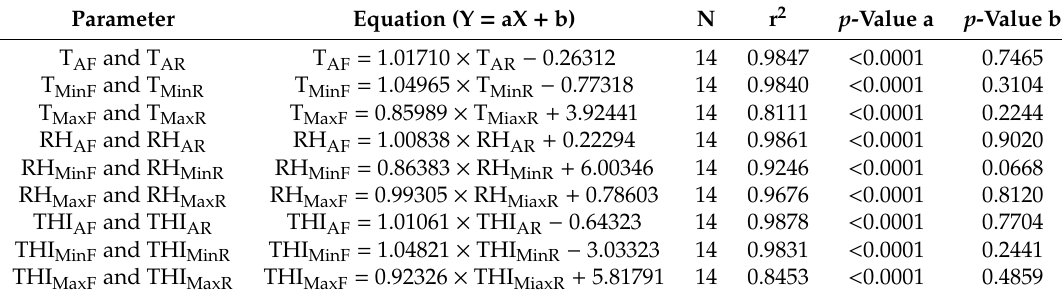
Table 4. Correlations between temperature (T), relative humidity (RH) and temperature humidity (THI) in front and rear loading space. The p -value of “a” is the p -value of the correlation coe ffi cient. T AF = average temperature in the front loading space; T AR = average temperature in the rear loading space; T MinF = minimum temperature in the front loading space; T MinR = minimum temperature rear loading space; T MaxF = maximum temperature front loading space; T MaxR = maximum temperature rear loading space. RH AF = average RH front in front loading space; RH AR = average RH in rear loading space; RH MinF = minimum RH in front loading space; RH MinR = minimum RH in rear loading space; RH MaxF = maximum RH in front loading space; RH MaxR = maximum RH in rear loading space. THI AF = average THI in the front loading space; THI AR = average THI in the front loading space; THI MinF = minimum THI in the front loading space; THI MinR = minimum THI in the rear loading space; THI MaxF = maximum THI in the front loading space; THI MaxR = maximum THI in the rear loading